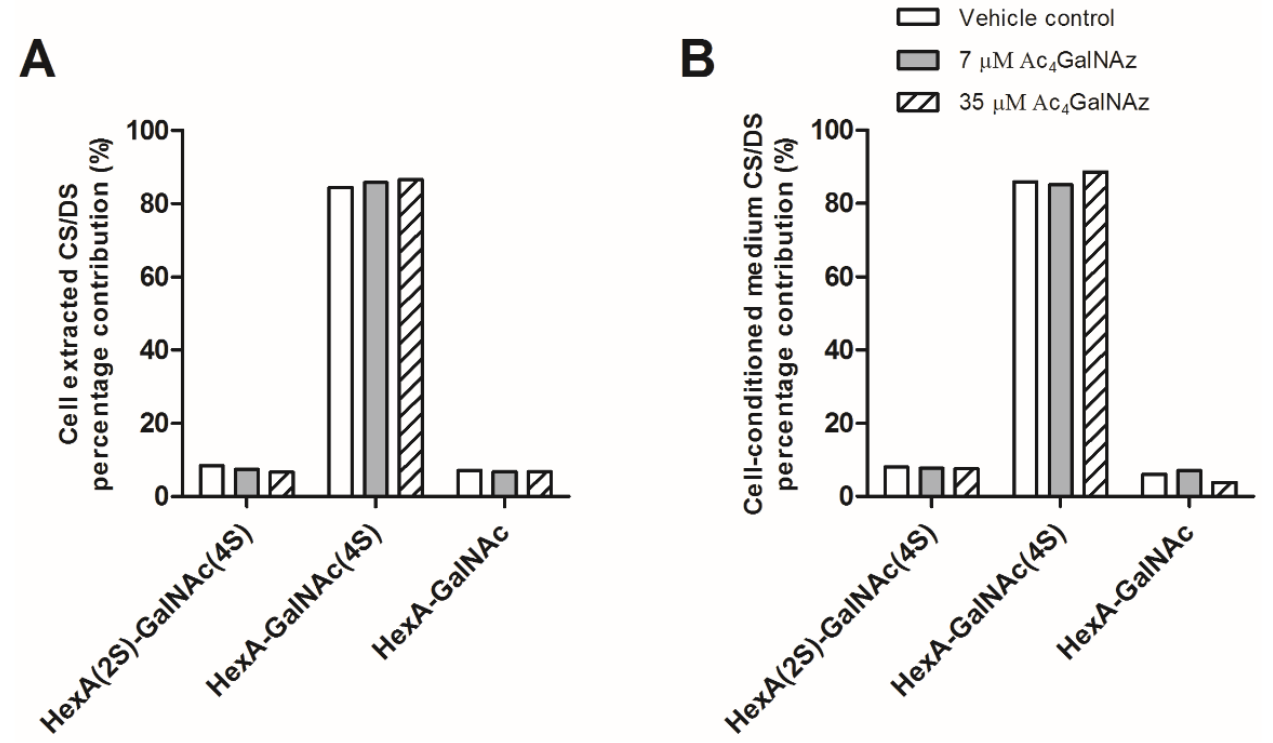
Figure 5. CS/DS disaccharide analysis from ( A ) CHO-K1 cell extracts and ( B ) cell-conditioned medium. Percentage contribution of CS/DS disaccharide species after SAX-HPLC of radiolabelled preparations. Other CS/DS disaccharide species were not detected. HexA, hexuronic acid (iduronic or glucuronic acid). 4S, 4-O-sulphate; 2S, 2-O-sulphate.